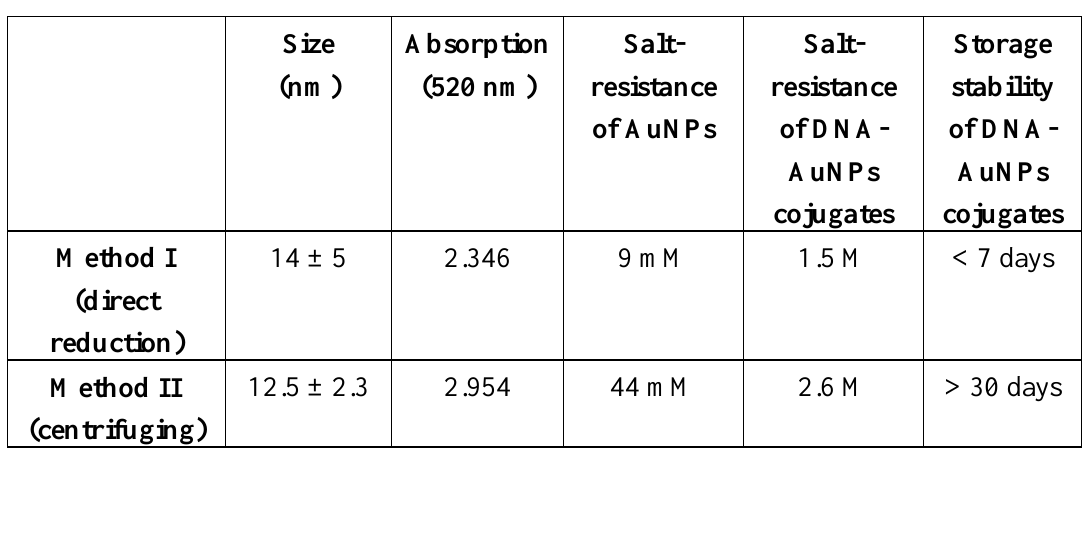
Table 1. Comparison of AuNPs preparation from method I and